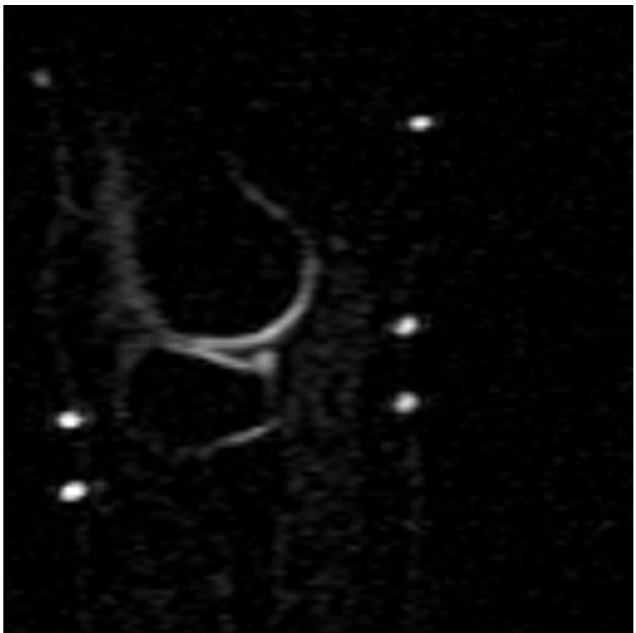
Figure 4. The 7 Tesla sodium image in the sagittal plane shows cartilage with high sodium content in the lateral femoral tibial joint cavity of the knee joint. Since sodium content correlates with the proteoglycan content of cartilage, which is related to the biomechanical properties of cartilage, a sodium image of cartilage provides biomechanical information. Note that even the thin cartilage layers of the proximal tibio-fibular joint are shown with sodium